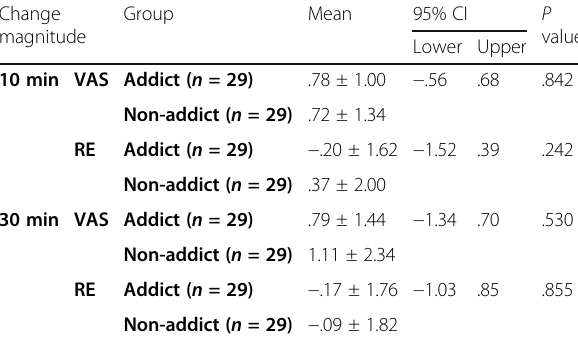
Table 1 Differences in the change magnitude of visual analog scale (VAS) and angle of repositioning error (RE) between the addict and non-addict participants Change